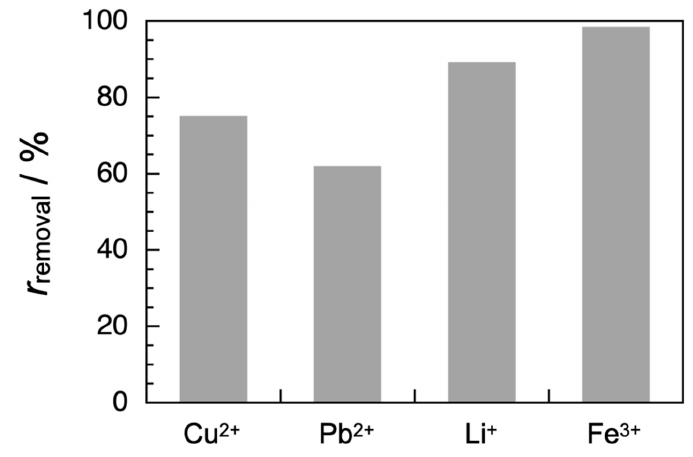
Figure 5. Removal ratio of poly(AH)Na for Cu 2+ , Pb 2+ , Li + , and Fe 3+ . Since Fe 3+ is a paramagnetic species, NMR relaxation may be significantly faster in the presence of Fe 3+ . Figure 6 displays 1 H NMR spectra for poly(AH)Na in the presence of varying concentrations of Fe(NO 3 ) 3 . The signals due to poly(AH)Na are only slightly broader at [Fe 3+ ] = 0.1 mM. At [Fe 3+ ] = 3.1 and 9.1 mM, on the other hand, the 1 H NMR spectra show markedly broader signals. It should be noted here that the signals due to the triazole and methine protons at ca. 8.2 and 6.0 ppm became weaker than did the signals due to the methylene protons at ca. 2.2. and 2.6 ppm. T 1 values of signals were measured and compared in 1 H NMR spectra in the presence and absence of 0.6 mM Fe 3+ (Table 3). Figure 7 indicates the ratios of T 1 values for the 1 H NMR signals in the presence and absence of 0.6 mM Fe 3+ . The ratio was 80.4% for the triazole proton at ca. 8.2 ppm, whereas those were 90.0–96.6% for the methine (6.0 ppm) and methylene protons (2.6 and 2.0 ppm). These observations indicate that Fe 3+ ions are adsorbed more preferably onto the 1,2,3-triazole residues [43,44]. Table 3. 1 H NMR chemical shifts and T 1 values for poly(AH)Na in the absence and presence of 0.6 mM Fe(NO 3 ) 3 . Polymers 2021 , 13 , x FOR PEER REVIEW